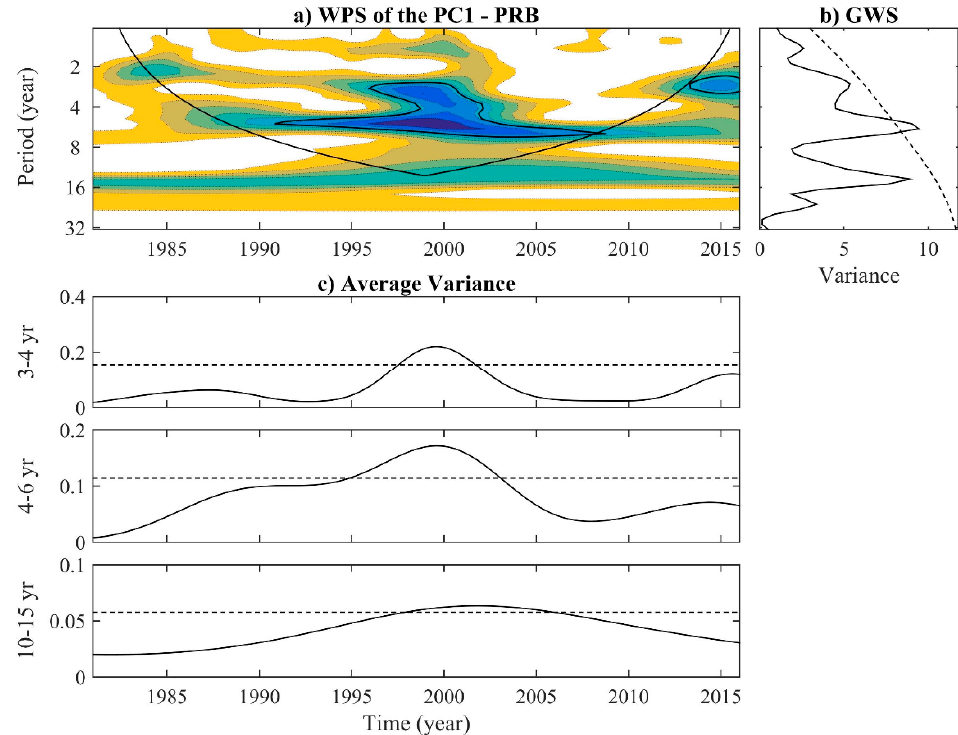
Figure 7. As in Figure 6, for the PC1 of the PRB.